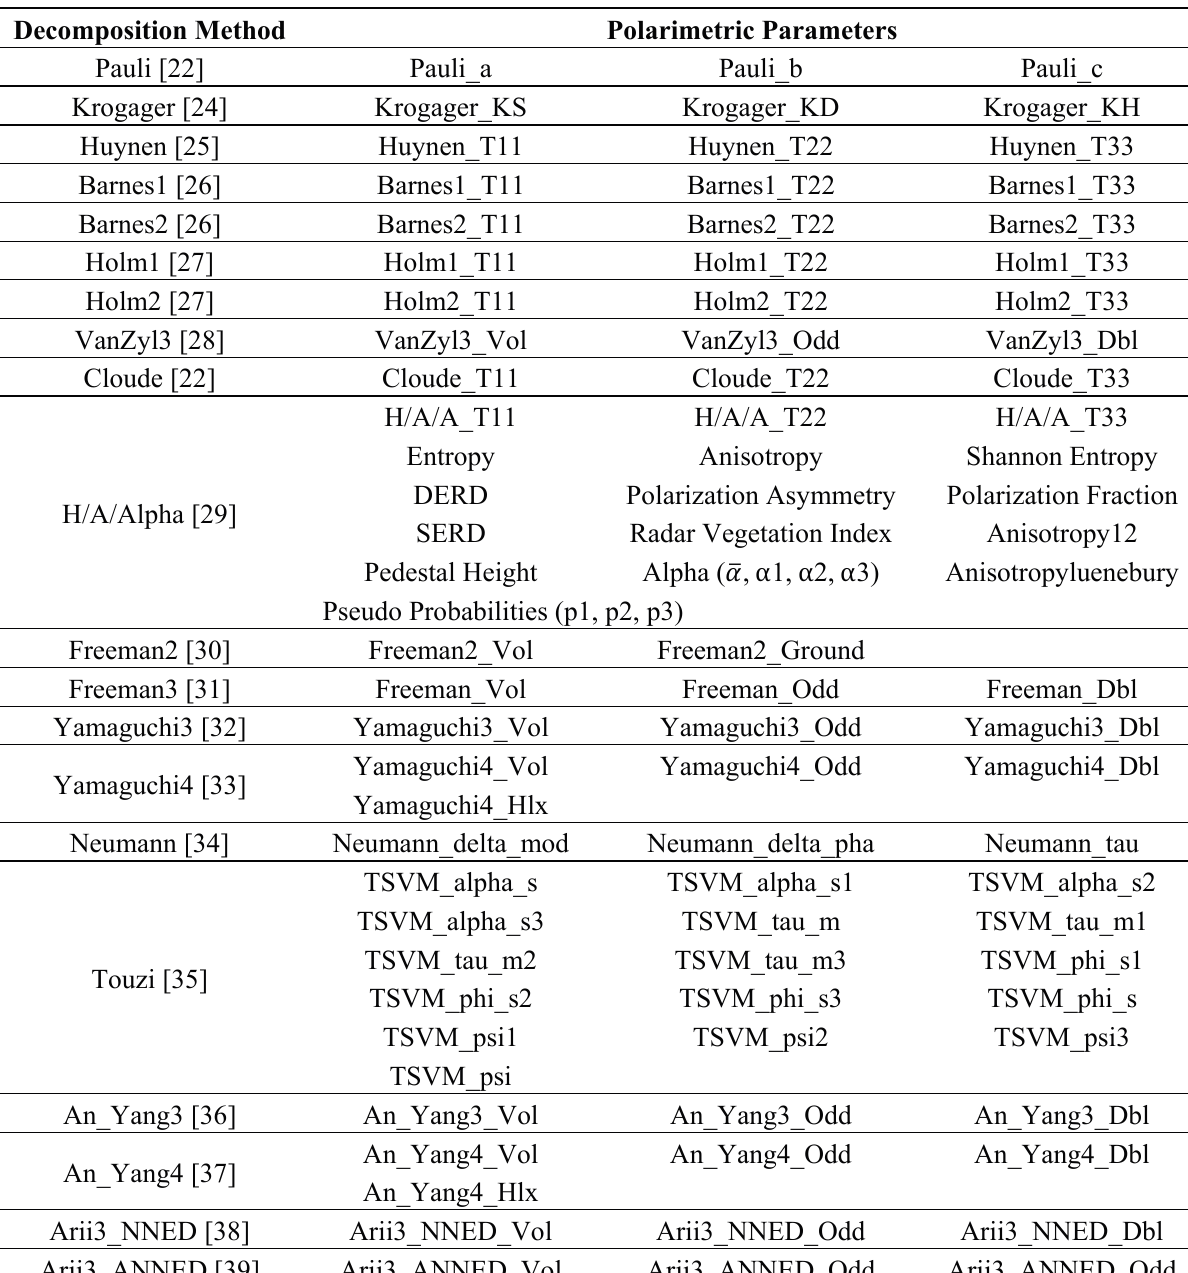
Table 1. Polarimetric parameters extracted from 20 polarimetric decompositions. Decomposition